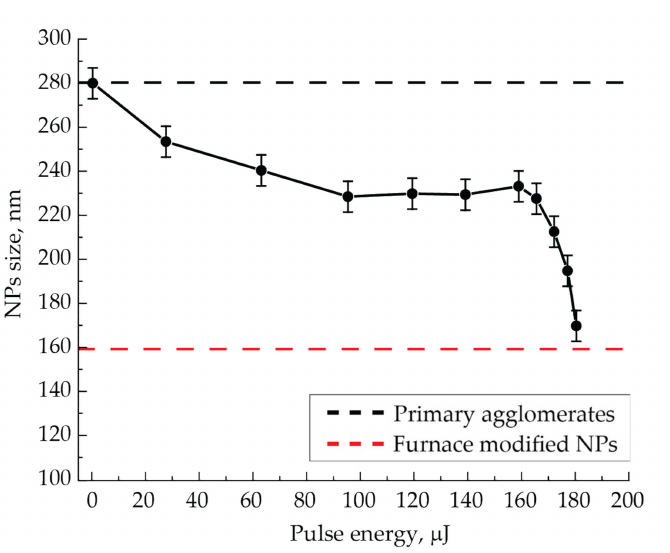
Figure 7. Dependence of NPs size at the output of the cell on pulse energy of laser radiation with the wavelength of 527 nm at the pulse repetition frequency of 500 Hz and the aerosol flow rate of 50